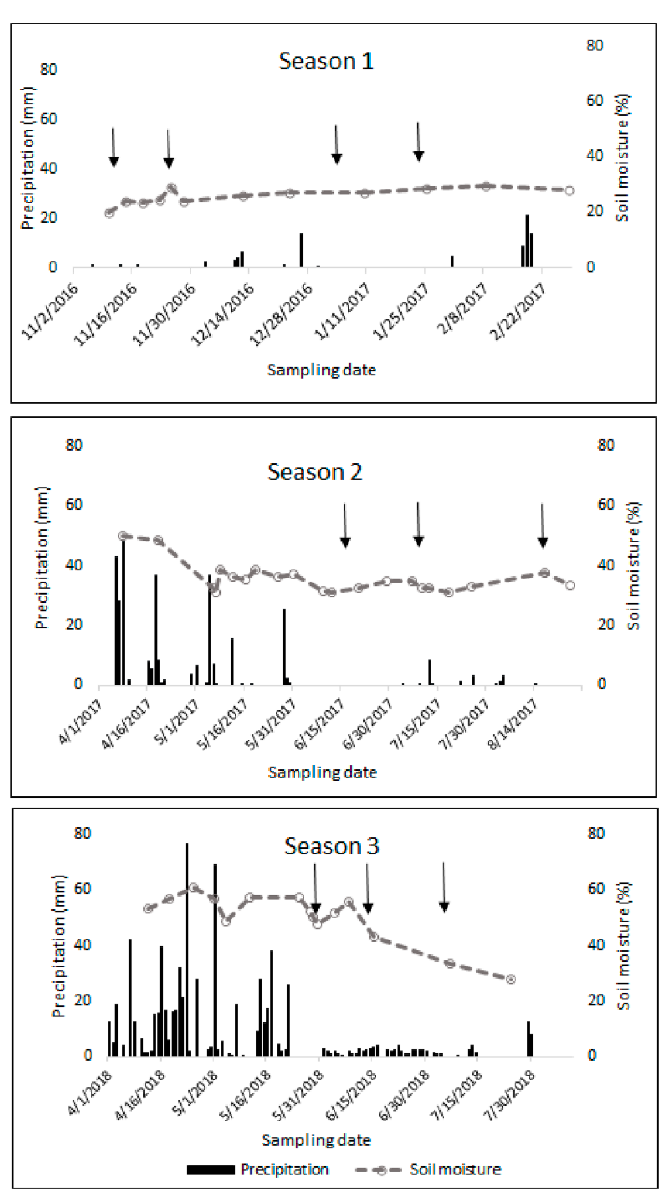
Figure 3. Average daily rainfall and gravimetric soil water content measured during gas sampling to a depth of 20 cm during three maize growing seasons: Season 1 (November 2016–February 2017), season 2 (April–September 2017), and season 3 (April 2018). Vertical arrows indicate supplemented overhead irrigation.